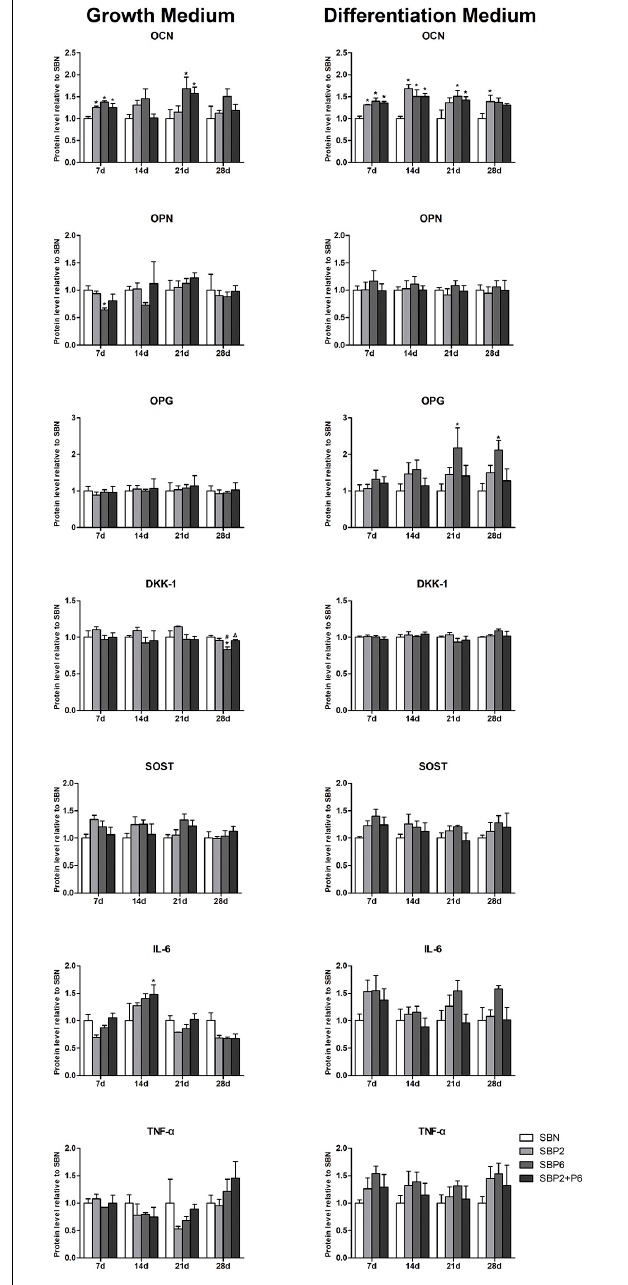
FIGURE 6 | The quantification results of specific extracellular protein (OPN, OPG, DKK-1, SOST, IL-6, and TNF- α ). Results were shown normalized to SBN at different time points. * p < 0.05 for when compared to SBN, # p < 0.05 for when compared to SBP2, (cid:49) p < 0.05 for when compared to SBP6 ( n =